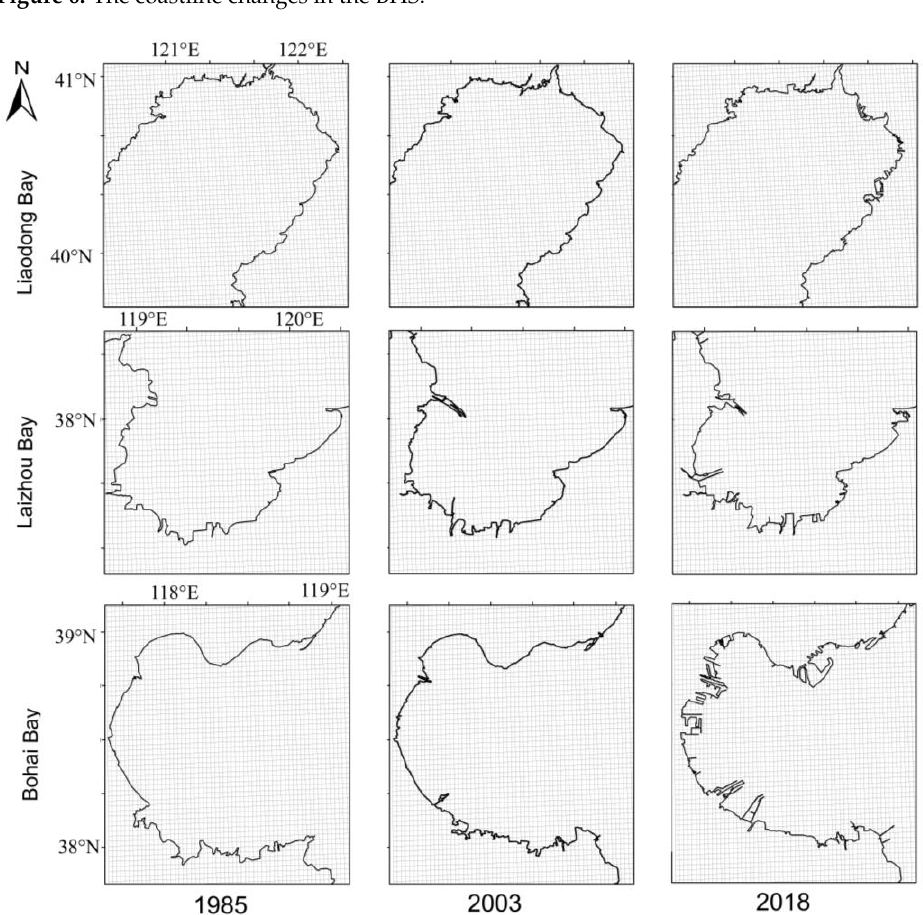
Figure 7. The coastline changes in the Laizhou Bay, Liaodong Bay, and Bohai Bay in different peri- ods.